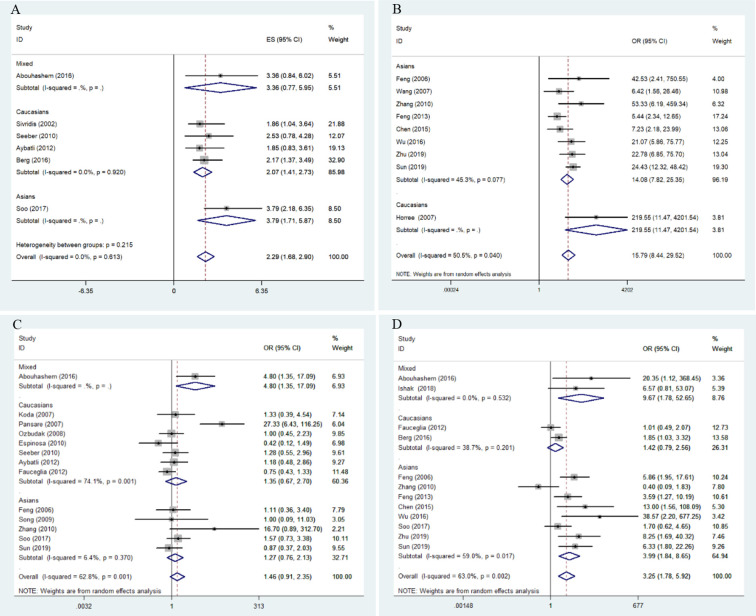
Forest plots for the association of risk, clinical features, and overall survival in endometrial cancer with HIF-1α expression. OR, odds ratio; CI, confidence interval; (A) overall survival in endometrial cancer; (B) risk of endometrial cancer; (C) stage of endometrial cancer; (D) lymphatic metastasis of endometrial cancer.